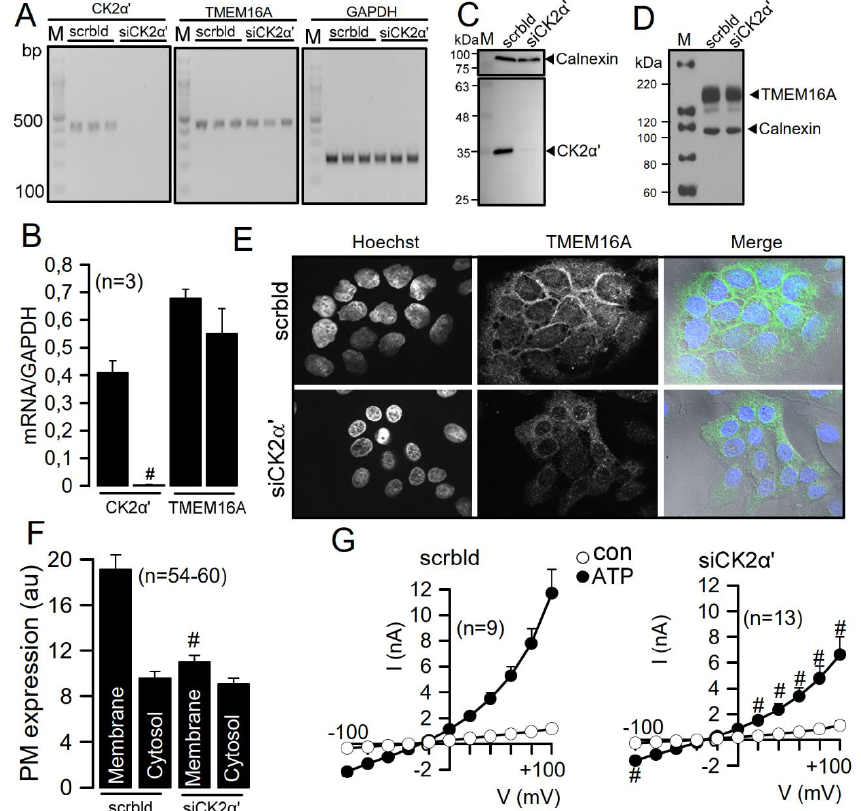
Figure 3. Role of CK2 for plasma membrane expression of TMEM16A in Cal33 head and neck cancer cells. ( A , B ) RT-PCR and densitometric analysis indicating successful knockdown of CK2 α ’ by siRNA for CK2 α ’ in Cal33 head and neck cancer cells (#significant inhibition, unpaired t -test; p = 0.01). Knockdown of CK2 α ’ did not inhibit transcription of TMEM16A. ( C , D ) Western blot analysis indicating successful knockdown of CK2α’ but unaffected expression of TMEM16A. ( E , F ) Plasma membrane (PM) expression of TMEM16A expressed endogenously in Cal33 cells and inhibition of PM expression by knockdown of CK2α’ (#significant inhibition, unpaired t-test; p = 0.00000002). ( G ) Current/voltage relationships of ATP-activated TMEM16A whole cells currents, indicating inhibition of TMEM16A by knockdown of CK2α’ (#significant inhibition, unpaired t-test; p = 0.01). Mean ± SEM. In parentheses are numbers of experiments.